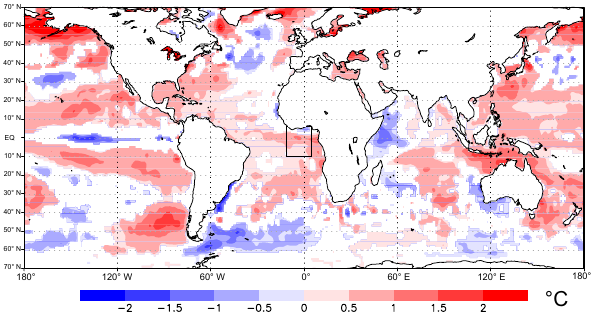
Figure 2. Global SST anomalies for June–July 2016 ( ◦ C). Basis is the Reynolds Optimal Interpolated SST v2 dataset and anomalies are relative to 1981–2016. Only anomalies above the 95% confi- dence level based on a two-sided Student’s t test are plotted. The black box marks the area used for Fig. 3.